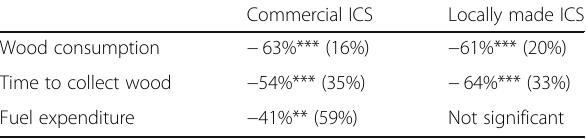
Table 3 Savings due to ICS distribution in CAR